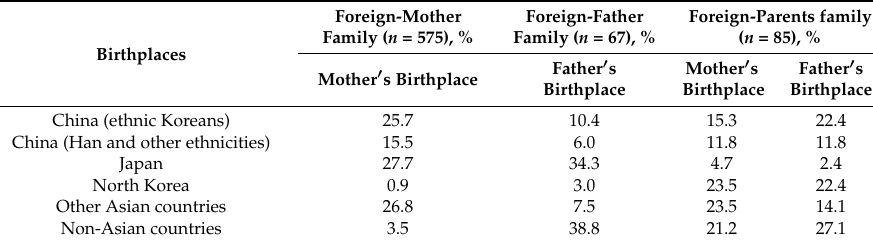
Table 1. Birthplaces of parents in multicultural